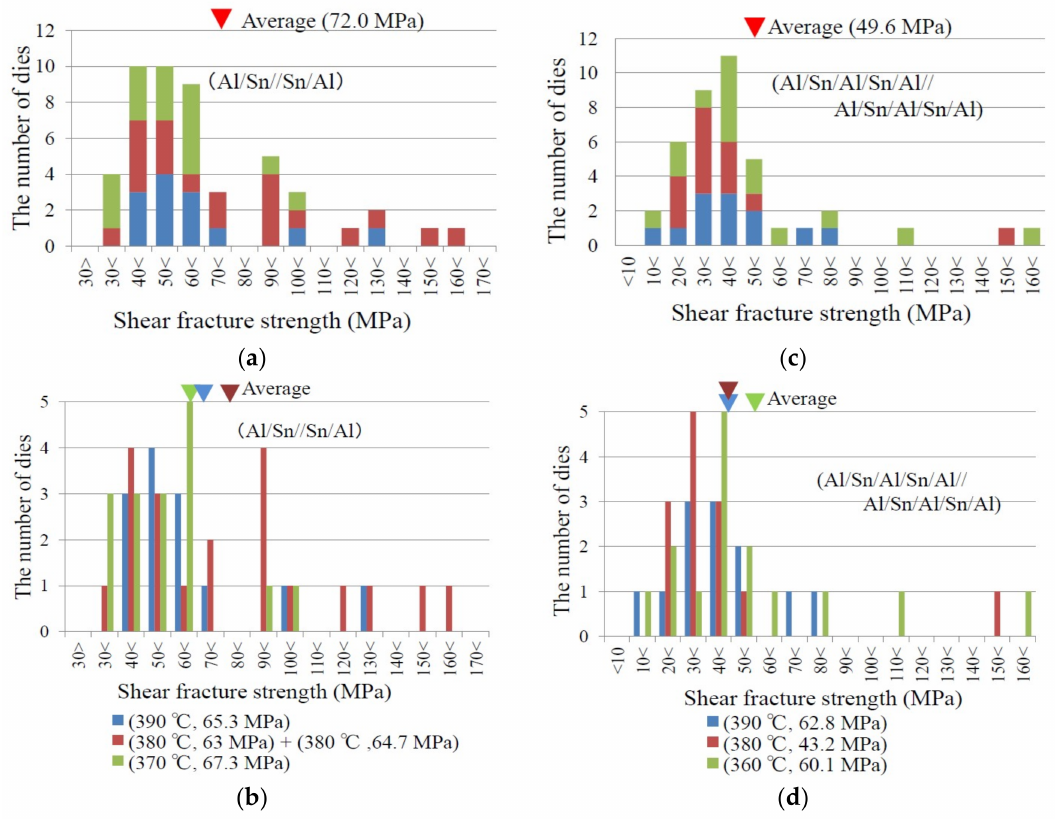
Figure 5. Shear fracture strength distributions for ( a , b ) Al/Sn//Sn/Al bonding layer structure and ( c , d ) Al/Sn/Al/Sn/Al//Al/Sn/Al/Sn/Al bonding layer structure. The upper graphs ( a , c ) show the total number of samples at each strength range regardless of bonding temperature. The lower graphs ( b , d ) show the number of samples for each bonding temperature at each strength range. The bonding temperature and pressure are shown in the graphs ( b , d